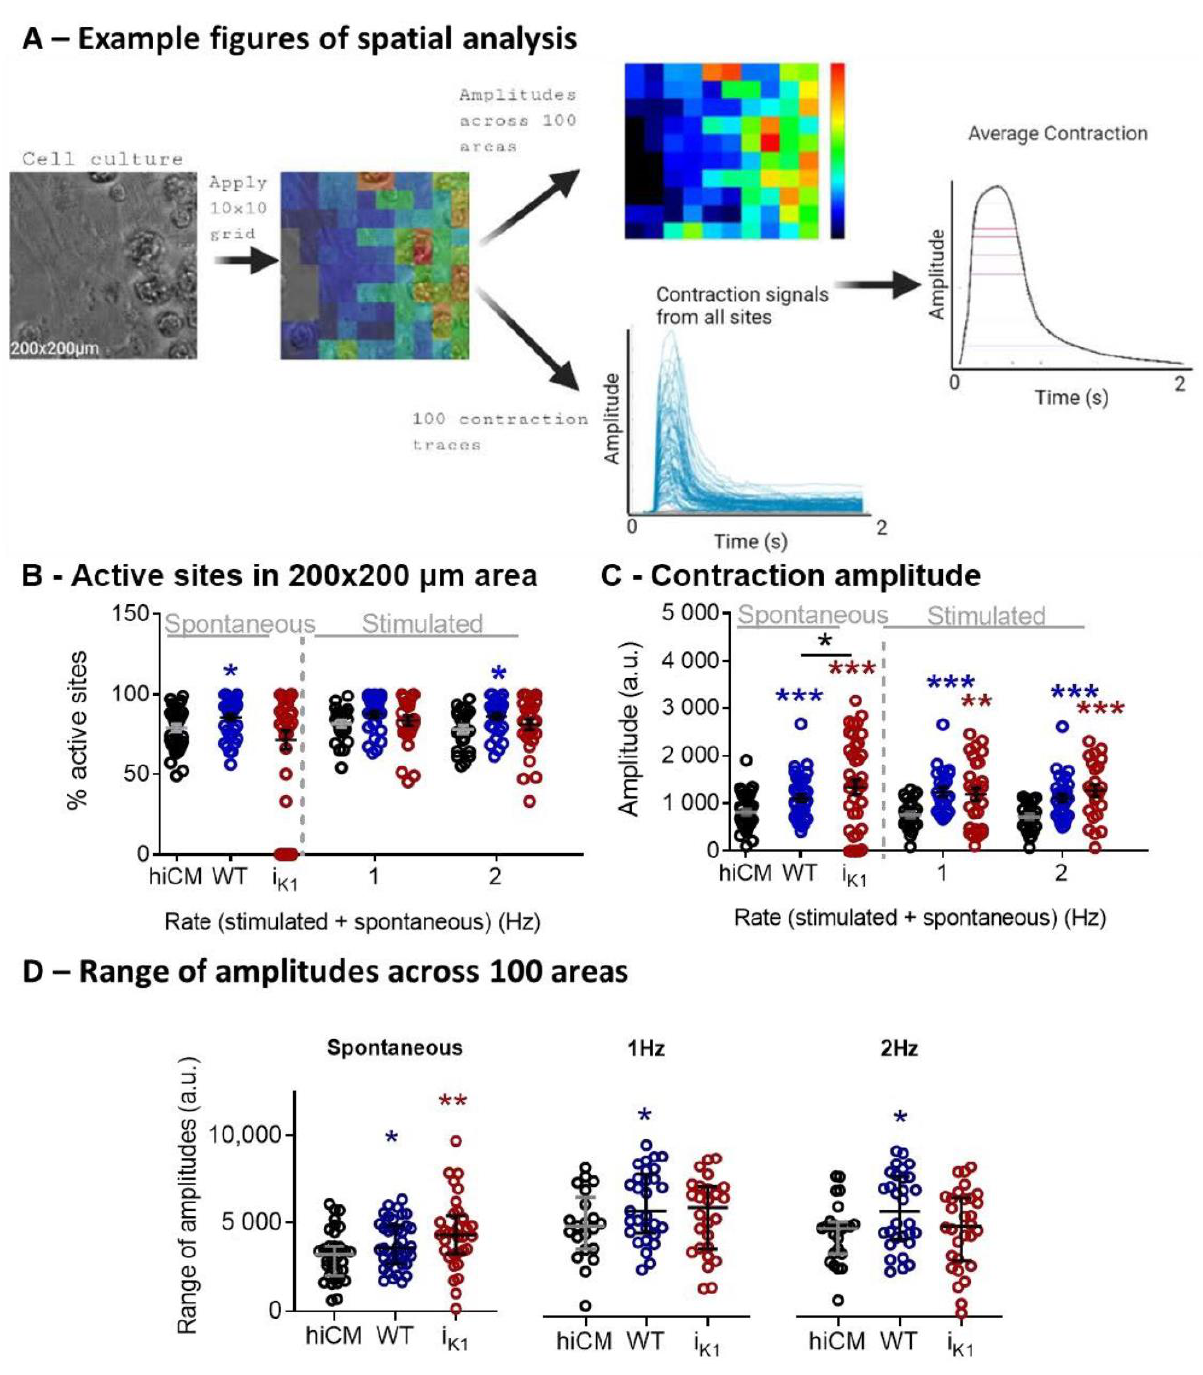
Figure 3. Spatial analysis of 1:1 HEK:CM on day 4 in culture in serum-free medium. ( A ) Example images obtained using spatial analysis of contractile motion. A heat map showing amplitudes recorded in a 200 × 200 µm area using a 10 × 10 grid were derived from the brightfield image (left). The colors represent the amplitude of the contraction in each square. Contraction signals from all sites and the average contraction are also shown. ( B ) Percentage of active sites representing contractile cells in a 200 × 200 µm area. ( C ) The amplitude of the contraction determined by pixel displacement. ( D ) Mean of range of amplitudes across a 10 × 10 grid. Unpaired t-test: HEK-I K1 vs. HEK–WT (black) and hiCM vs. HEK–WT (blue) or HEK-I K1 (red). *** p < 0.001, ** p < 0.01, * p < 0.05, n > 28 cells, 5 platings.